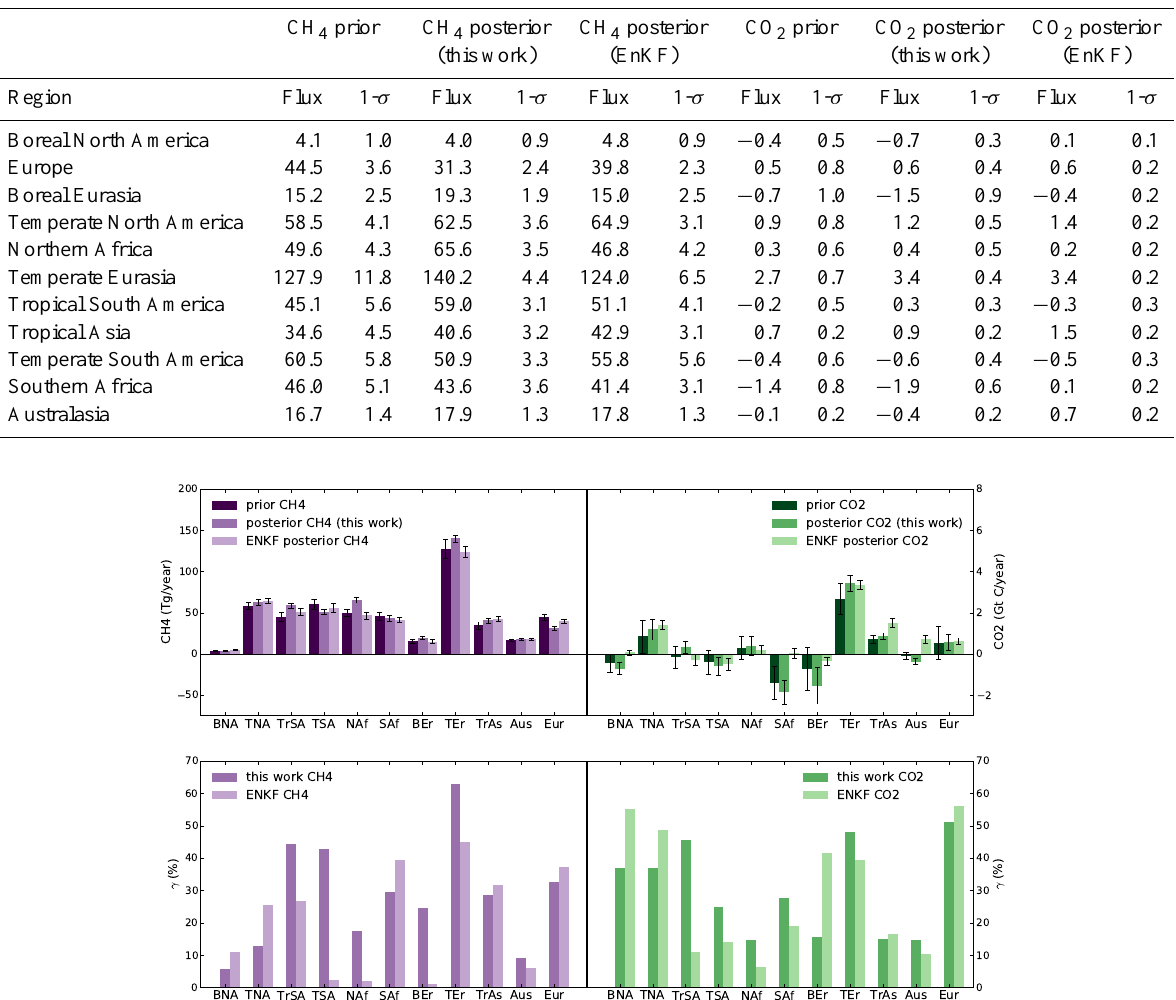
Table 2. A priori and a posteriori CH 4 and CO 2 regional land fluxes (natural+anthropogenic) and 1- σ uncertainties inferred from GOSAT XCH 4 : XCO 2 and in situ mole fraction measurements. Fluxes inferred from previous work – Fraser et al. (2013); Feng et al. (2011) – using an EnKF are denoted EnKF. CH 4 and CO 2 fluxes are reported as TgCH 4 year − 1 and GtCyear − 1 , respectively.